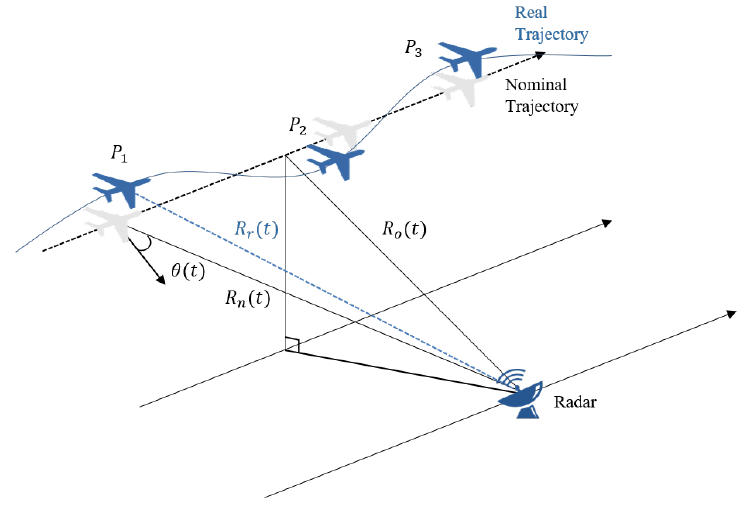
Figure 2. ISAR configuration with non-ideal target motion.